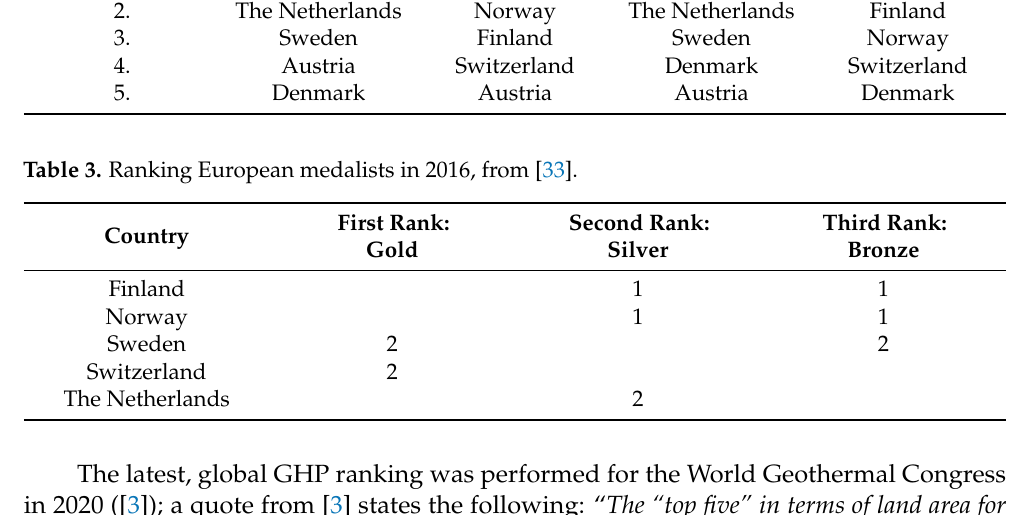
MW th per Capita